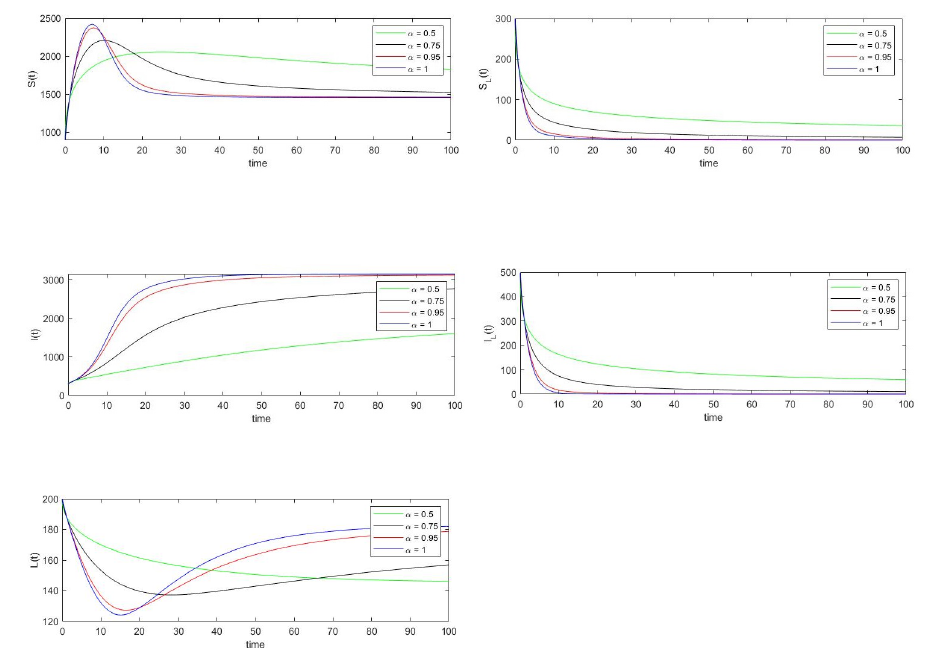
Figure 4. Approximated solution of system (8) using the residual power series method when R 0 > 1. The values of the parameters used in this figure are the same as in Figure 3.